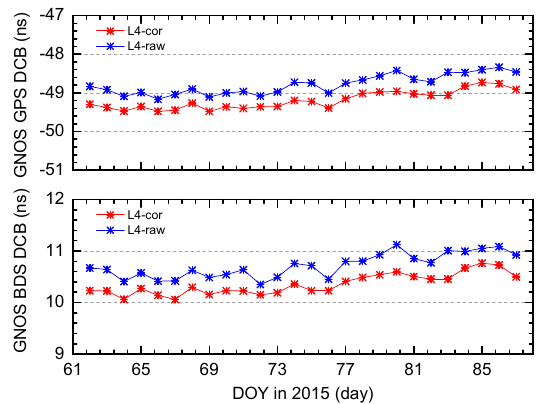
Figure 7. FY3C GNOS receiver DCB series during March 2015: ( Top ) the GPS DCB series; and ( Bottom ) the BDS DCB. The L4-cor and L4-raw solutions are displayed. Table 4. Monthly-mean DCBs of FY3C GNOS receiver and stabilities from L4-raw to L4-cor solutions.